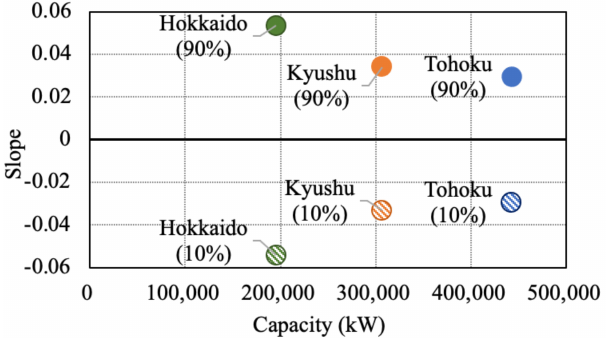
Figure 13. Slopes of the least-squares approximations of the 10th and 90th percentiles versus the wind power capacity in each balancing